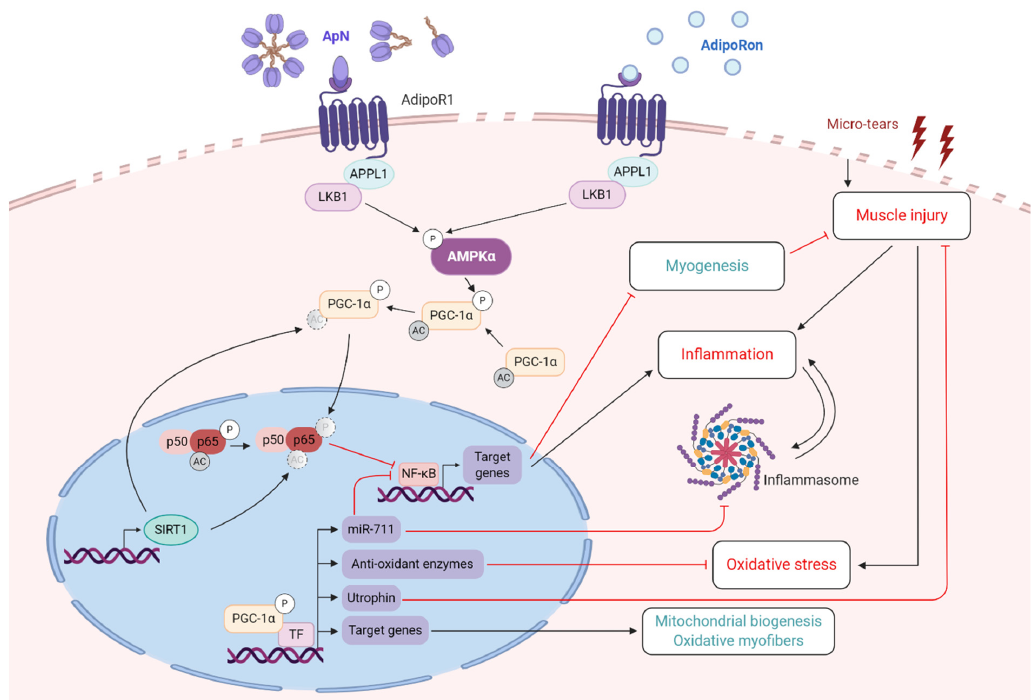
Figure 4. Adiponectin/AdipoRon properties on diseased skeletal muscle. This figure summarizes the beneficial and protective effects of ApN and AdipoRon on dystrophic skeletal muscle, which is characterized by micro ‐ tears in the sarcolemmal membrane due to lack of dystrophin protein. It also highlights their mechanisms of actions. Briefly, binding of either ApN or AdipoRon to AdipoR1 will activate AMPK-SIRT1-PGC-1 α pathway. Then, PGC-1 α represses NF- κ B activity by de-phosphorylation